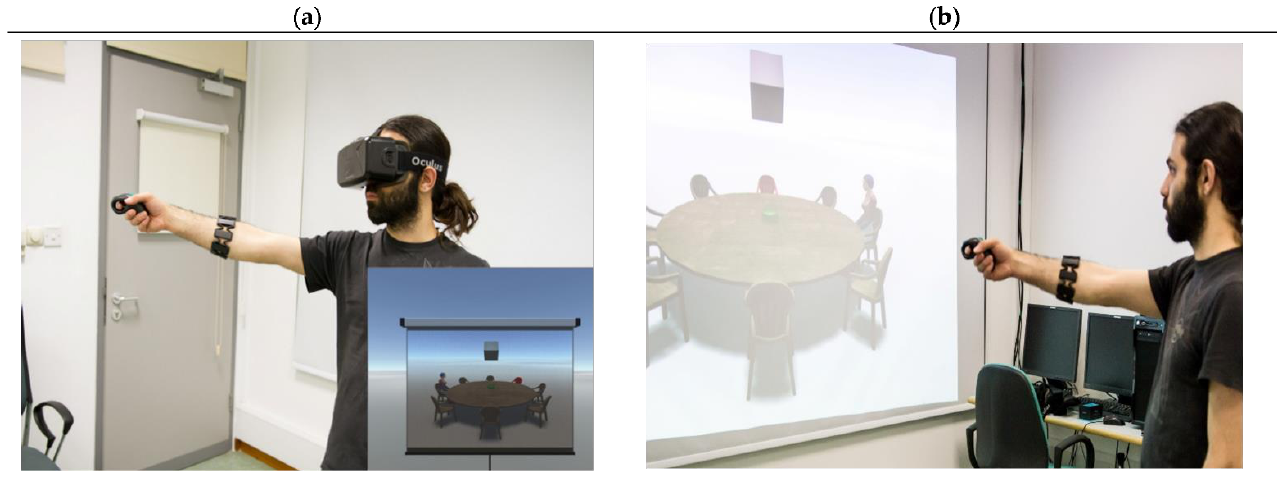
Figure 1. Example of a participant carrying out the pointing task in the Virtual Environment (VE) condition ( a ) and the Real Environment (RE) condition ( b ) of Experiment 1. In the VE condition, the participant is immersed in a virtual environment that contains a projector screen. The spatial scene is represented as 2D images on the virtual screen. In the RE condition, the spatial scene is presented as a 2D image on an actual projector screen in the laboratory.